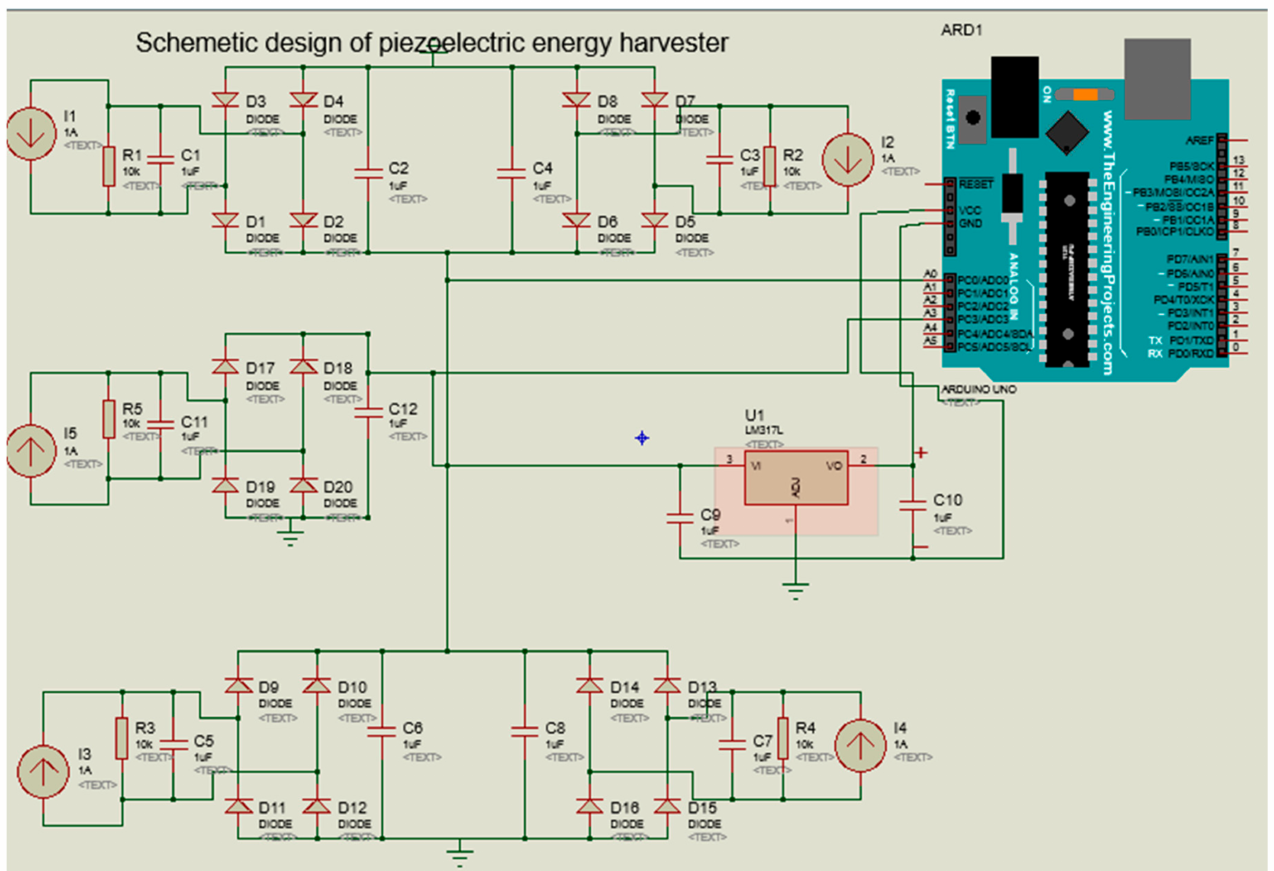
Figure 5. Schematic diagram of piezoelectric energy harvester based on transducer and bees’